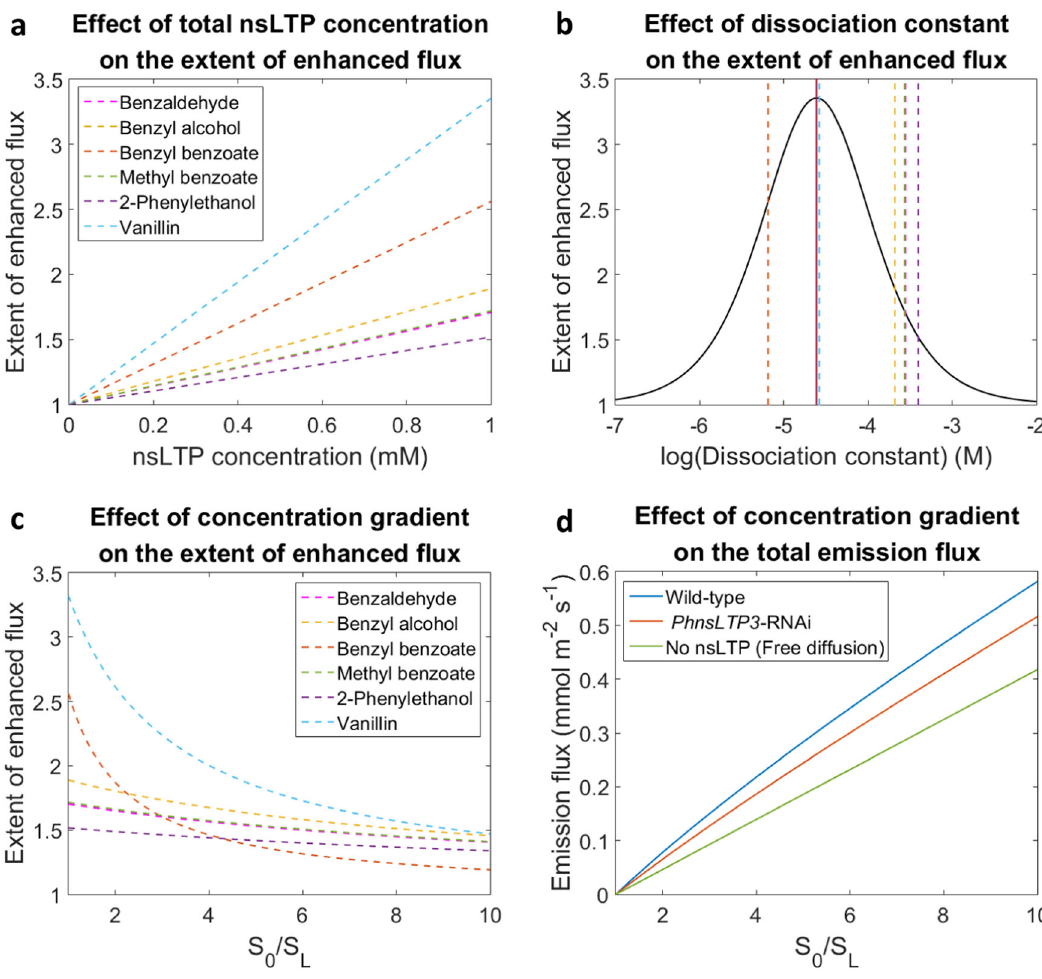
Fig. 6 | Mathematicalsimulations ofVOCemissionrates asfunctions ofnsLTP vanillin(lightblue),benzylalcohol(yellow),methylbenzoate(green),benzaldehyde abundance, af fi nity and VOC concentration gradient across the cell wall. The (pink),and 2-phenylethanol(purple) from left to right, respectively. c The extent of enhanced fl uxwasplottedagainstdifferent S 0 / S L ratiosata fi xednsLTPlevel(1mM) effectoftotalnsLTPconcentration( a )anddissociationconstant( b )ontheextentof enhanced fl ux, and concentration gradient across the cell wall ( S 0 / S L ) on the extent and measured respective dissociation constants. d The total emission fl ux was of enhanced fl ux ( c ) and the total VOC emission fl ux ( d ). a The extent of enhanced plottedagainstdifferent S 0 / S L ratiosassumingnsLTPlevelsinwild-type1mM(blue), fl ux was plotted against different nsLTP levels at a fi xed S in PhnsLTP3 -RNAi fl owers0.6mM(orange),andnonsLTP(green).Abbreviations: S 0 / S L ratio and measured respective dissociation constants. b The extent of enhanced fl ux (black line) was plottedagainstdifferentdissociationconstantsata fi xed S 0 / S L ratioandnsLTPlevel (1mM). The vertical red line indicates the predicted optimal dissociation constant, and the six vertical dotted lines show the experimentally obtained in the TNS- binding assay dissociation constants of PhnsLTP3 with benzylbenzoate (orange),